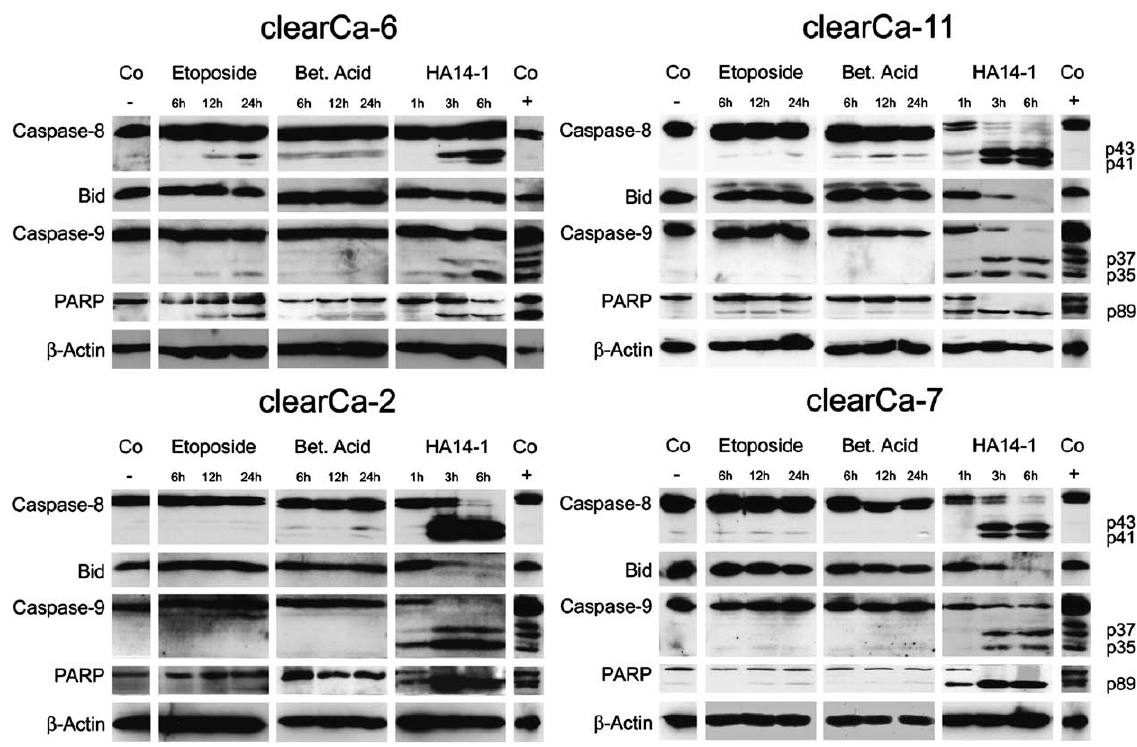
Fig. 4. Western Blot analysis of caspase-8-, caspase-9- and PARP-cleavage after exposure to etoposide, HA14-1 and betulinic acid. Caspase-8, caspase-9 and PARP-cleavage as well as reduction of Bid whole protein only after exposure to the BCL-2-antagonist HA14-1 in all cell lines after 1–3 h indicating an increased apoptosis-induction with activation of the mitochondrial pathway. Only weak detection of active cleavage products of the initiator caspase-8 with minimal caspase-9- and PARP-cleavage after exposure to etoposide in clearCa-6. No caspase-, Bid- or PARP-cleavage in all cell lines after exposure to betulinic acid. (HELA cells treated with 25 µg/ml etoposide for 24 h were used as positive control for caspase-9 and PARP cleavage.)